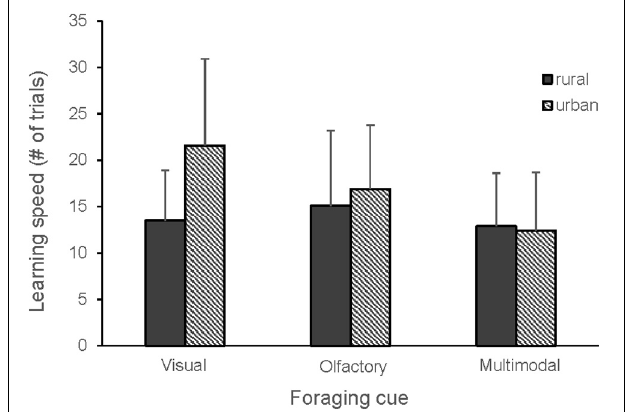
FIGURE 3 | Learning speed in urban ( n = 15) and rural ( n = 17) great tits for visual, olfactory and multimodal foraging cues. Mean number of trials and standard deviation are shown. The cues tested: visual (blue, yellow), olfactory (MeSA, MeJA, vanilla), multimodal (blue + MeSA, blue + MeJA, blue + vanilla, yellow + MeSA, yellow + MeJA, yellow + vanilla, green + MeJA). Thirty birds learned two cues each and a single bird learned five cues. There was a tendency for higher learning speed of visual cues in urban birds (GLMM, p =